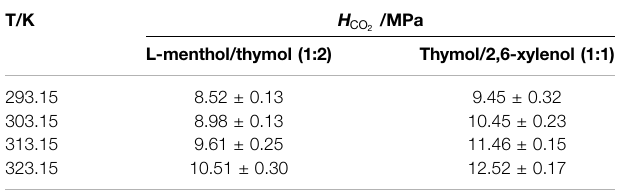
) in the thymol/2,6-xylenol (T26X) eutectic 2